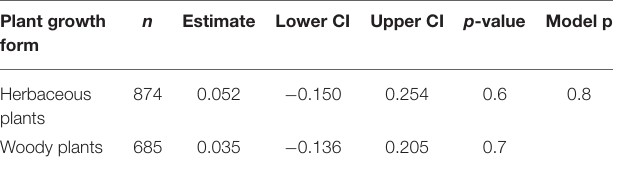
TABLE 3 | Effect sizes (LnRR) of SRR to N fertilisation for different plant growth forms.